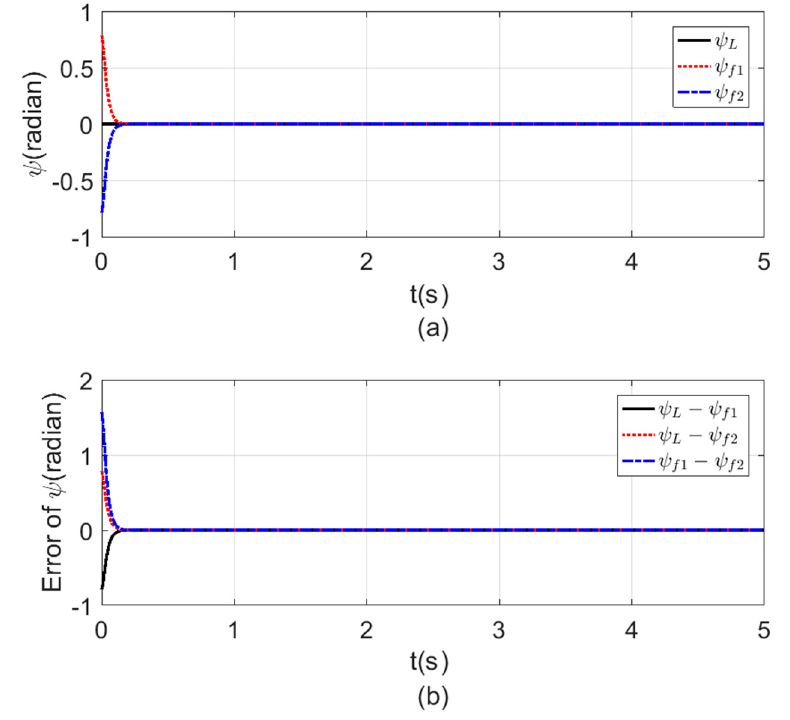
Figure 11. Consensus in ψ -angle ( a ) ψ -angle time response. ( b ) Error of the ψ Figure 11. Consensus in (cid:2032) -angle ( a ) (cid:2032) -angle time response. ( b ) Error of the (cid:2032) angle. Figure 11. Consensus in (cid:2032) -angle ( a ) (cid:2032) -angle time response. ( b ) Error of the (cid:2032) angle.